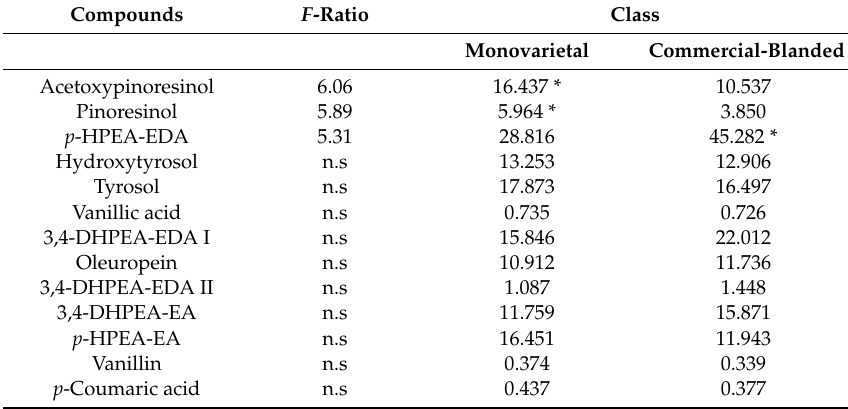
List of phenols found in monovarietal Protected Designation of Origin (PDO) and commercial-blended extra virgin olive oils by high-performance liquid chromatography with diode-array and mass spectrometric detection (HPLC-DAD-ESI / MS) sorted by descending Fisher F -ratio, phenol class, and concentration (mg / kg). An asterisk (*) in a row represents significant differences between mean values at p < 0.05 obtained by ANOVA and least significant difference (LSD)